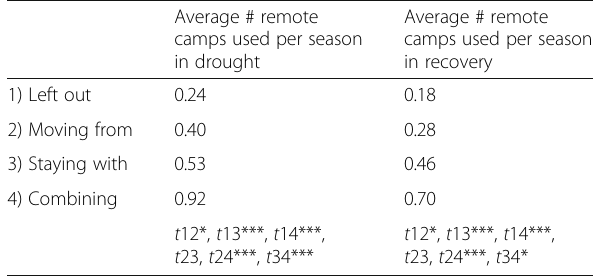
Table 6 Number of remote (satellite) camp water points used per season during the drought and recovery by group Average # remote camps used per season